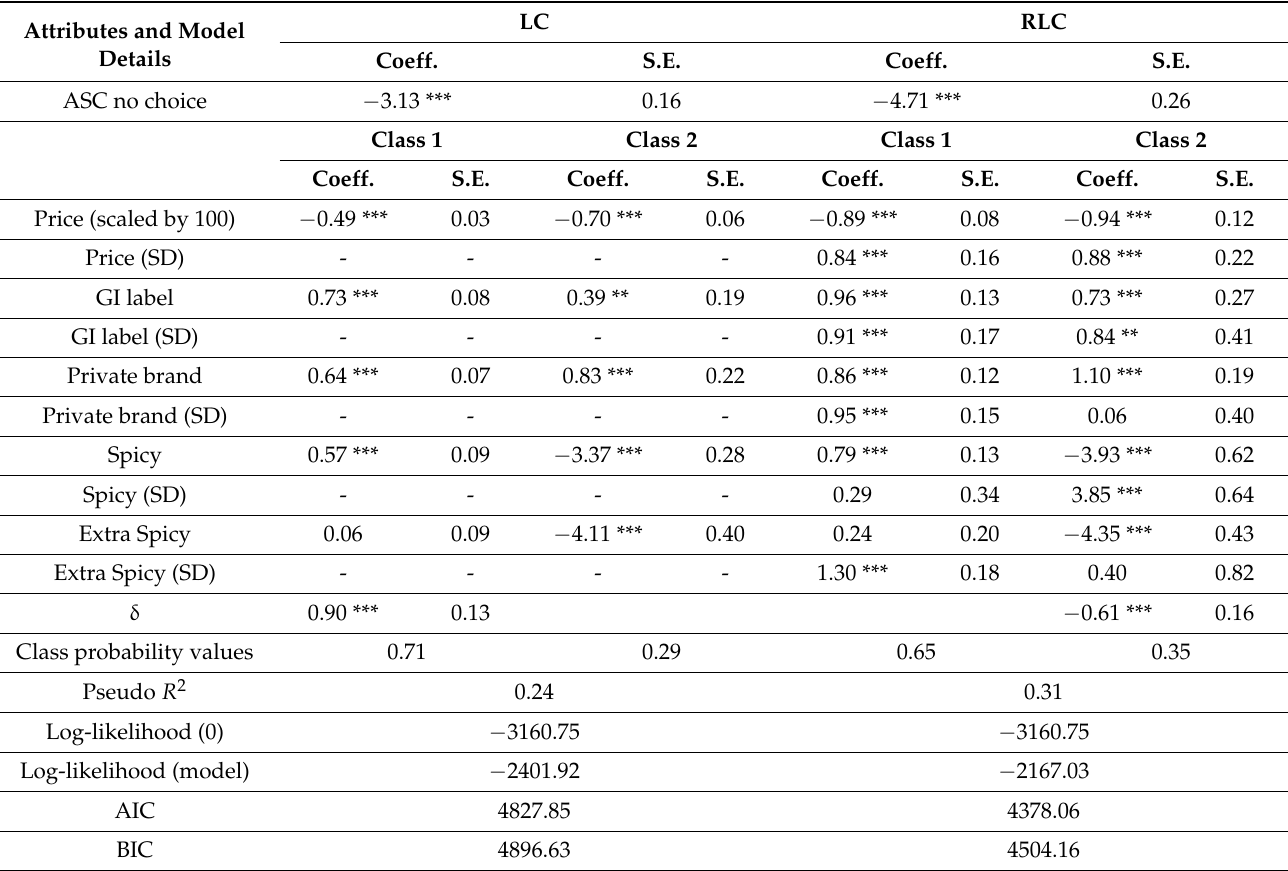
Table 5. Coefficient estimates by two classes latent class and random parameter latent class models.